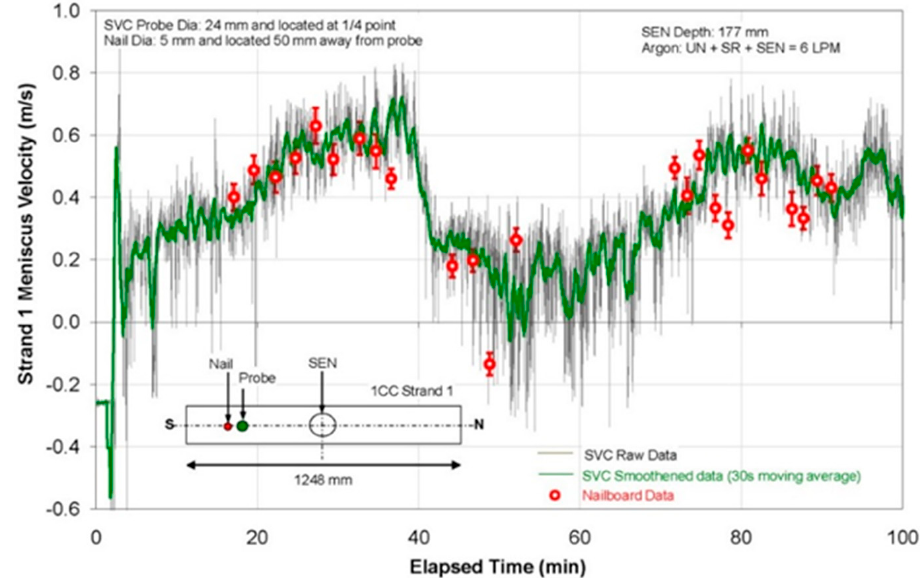
Figure 3. Comparison of surface velocity history between submeniscus velocity control (SVC) and nail dipping measurements [62].